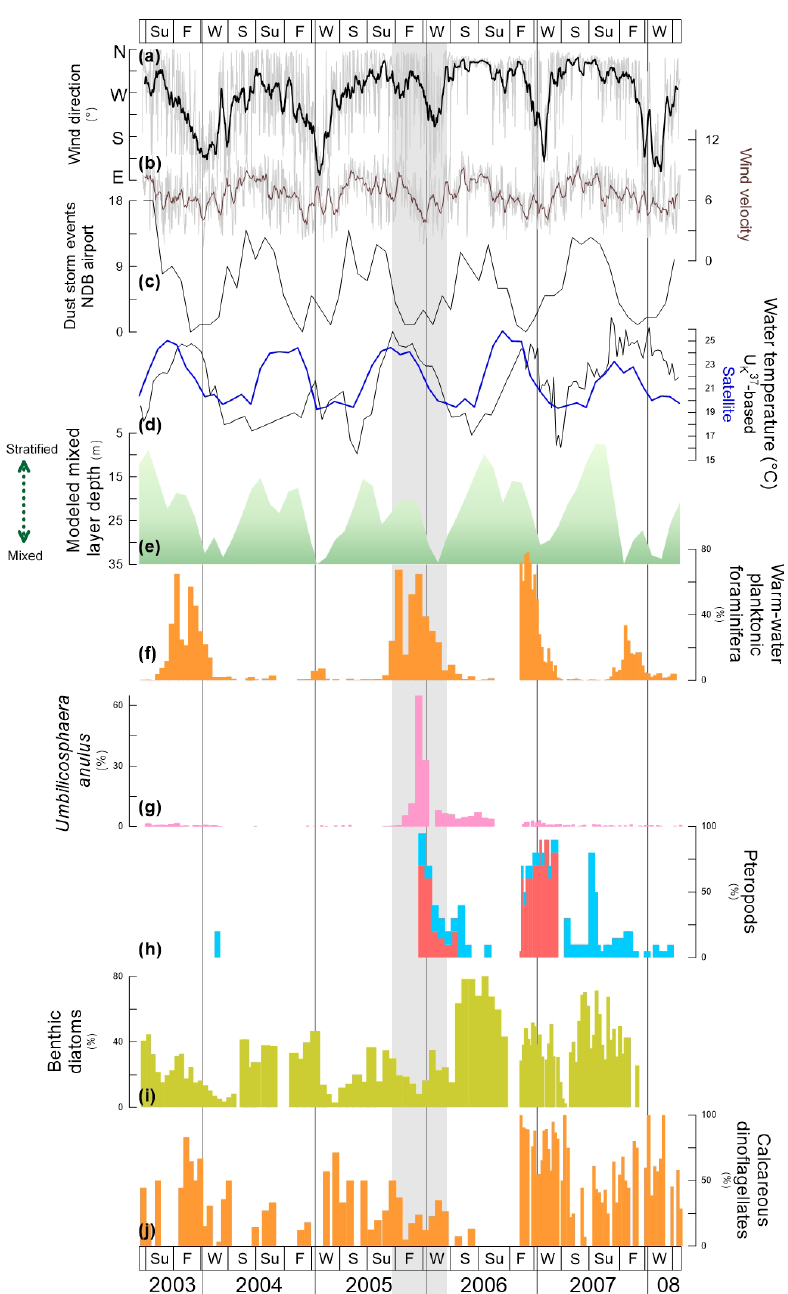
Figure 7. Comparison of physical data (a–e) and relative abundance of selected species or group(s) of species (f–j) at site CBeu between June 2003 and March 2008. Physical data: (a) origin of daily wind direction (the gray line are daily data, the thicker black line represent the 17-running point average); (b) daily wind velocity (ms − 1 , the gray line are daily data, the thicker dark brown line represent the 17-running point average), (c) dust storm event (number of events) recorded at the meteorological station of the airport of Nouadhibou (ca. 20 ◦ 57 (cid:48) N, (cid:48) 17 ◦ 02 (cid:48) W, Mauritania); (d) seawater temperature ( ◦ C): U K -based reconstruction (black line) and satellite-imagery-generated data (blue 37 line); (e) mixed layer depth (m, gray line, https://modis.gsfc.nasa.gov, last access: 12 November 2019 for the area between 19–18 ◦ W and 20–21 ◦ N). Relative contribution (%) of (f) warm-water planktonic foraminifera (orange bars); (g) the coccolithophore U. anulus (pink bars); (h) pteropods L. bulimoides (red bars) and uncoiled species (light blue bars); (i) benthic diatoms (banana yellow bars); and (j) calcareous dinoflagellates (light orange bars). The species-specific composition of groups is presented in Table 5. The vertical gray lines indicate years separation. The light gray shading in the background highlights the interval of main shift in flux values and/or the relative contribution of particular species or groups of species (see discussion in Sect. 5.3.). For interpretation of the references to color in this figure legend, the reader is referred to the web version of this